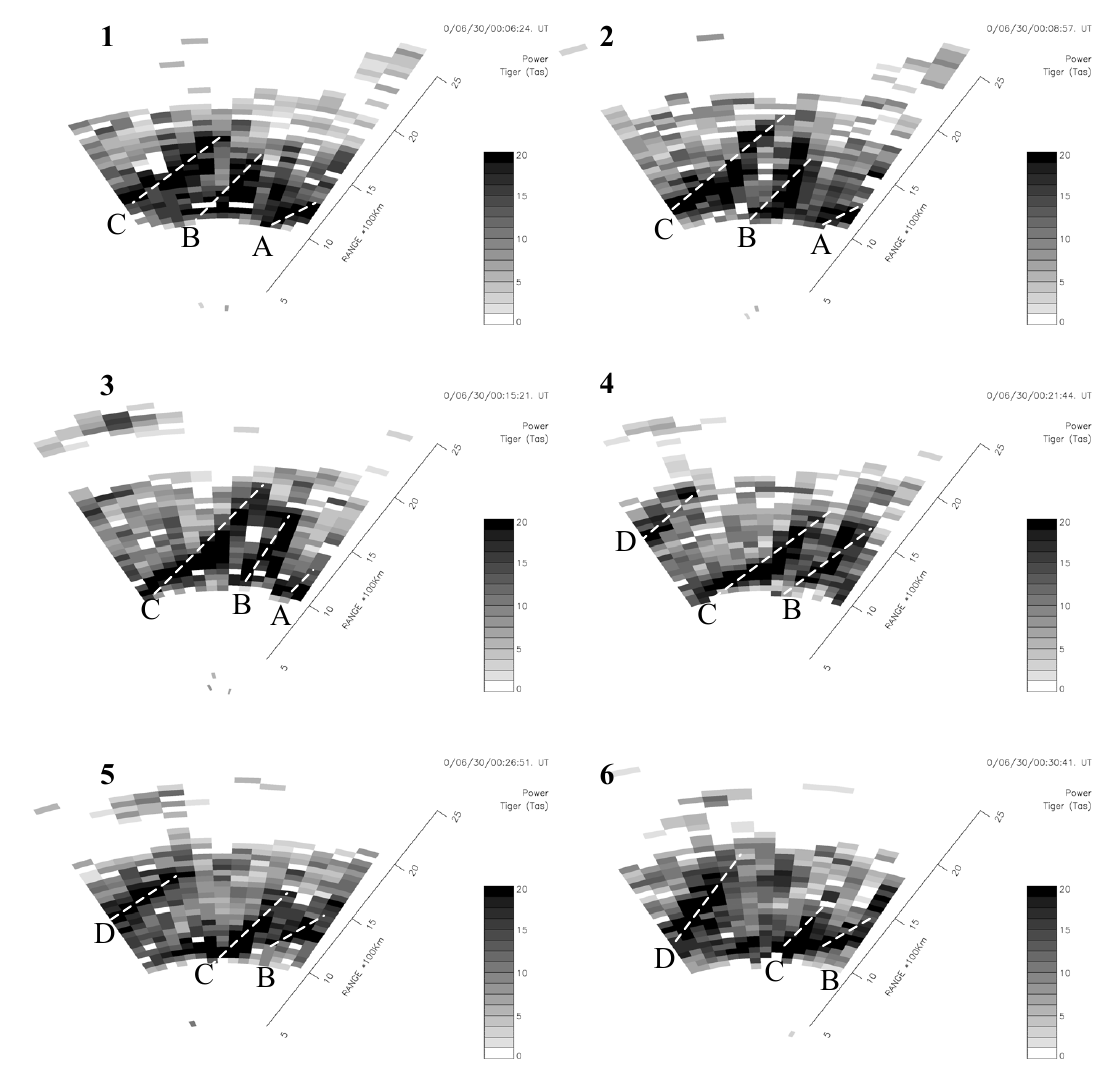
Fig. 3. A selection of TIGER full scans recorded during 00:06:24 to 00:30:41 UT on 30 June 2000. The parameter shown is sea echo power in dB, and has not been band-pass filtered. Beam 0, the westernmost beam, is on the left, and the radar scans from east to west, i.e. from beam 14 to beam 0. Beam 15, the easternmost beam, was not used. The equatorward direction is downwards on the plot. The wavefronts formed by the stronger echoes are shown in solid lines. The propagation direction of waves can be clearly seen from the left top to the right-bottom, i.e.